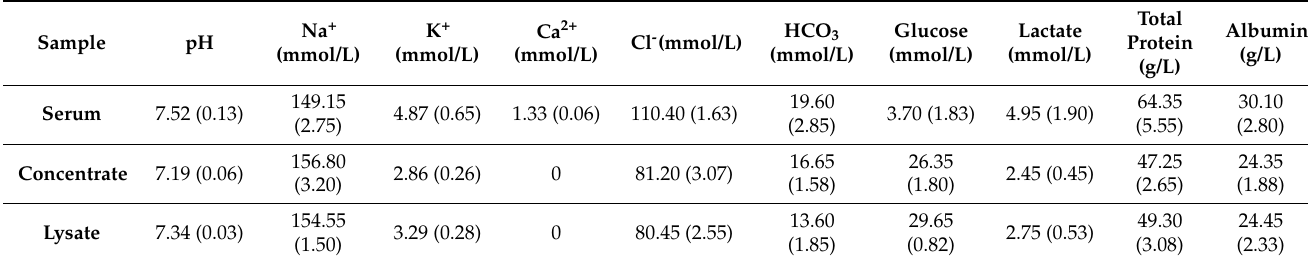
Table 1. Chemical analyses during blood processing. Data from n = 12 donors are presented as median (IQR)